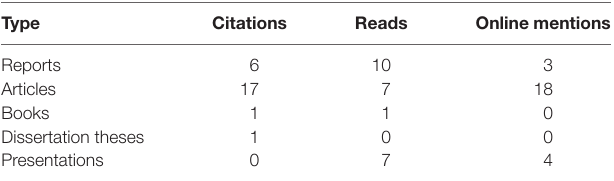
TaBle 4 | Document categories according to each Top 25 author-level metric (AutLM) performance ranking.